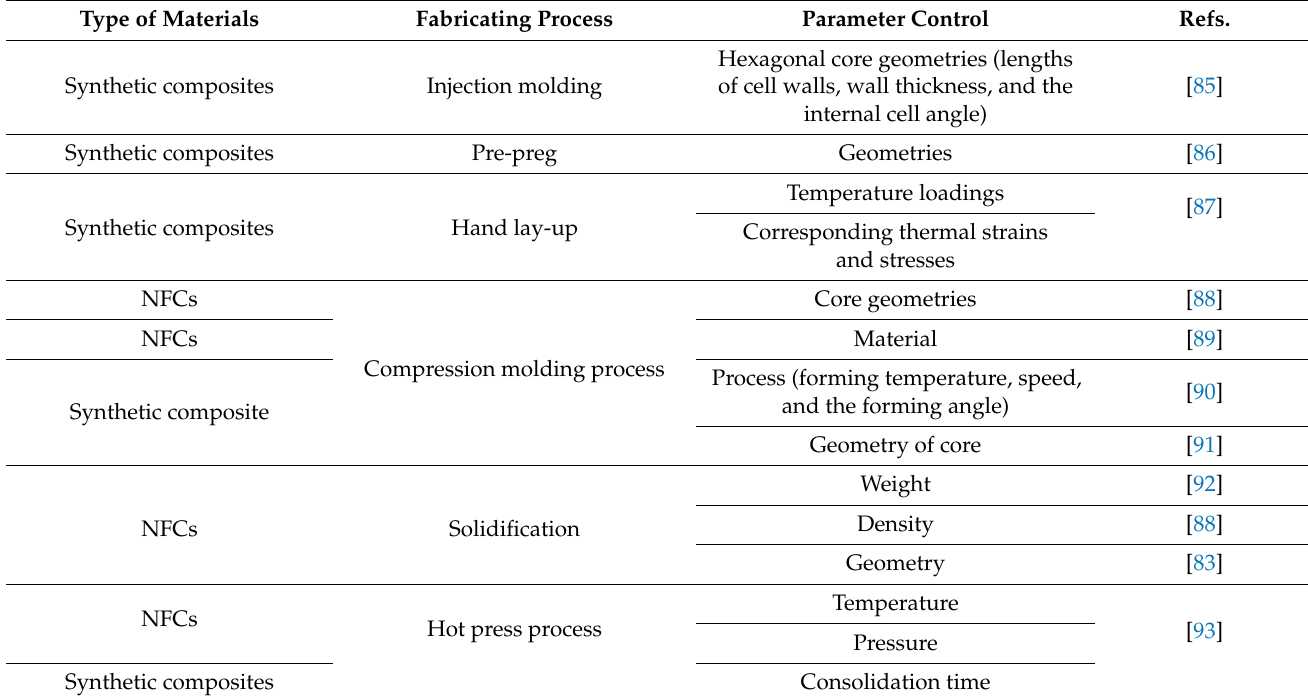
Table 3. Core fabrication